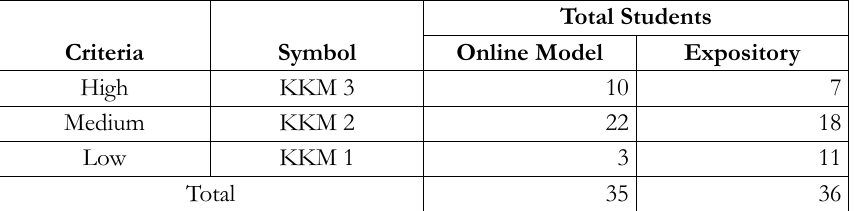
Table 4. Total of Students Based on the Category of Minimum Score